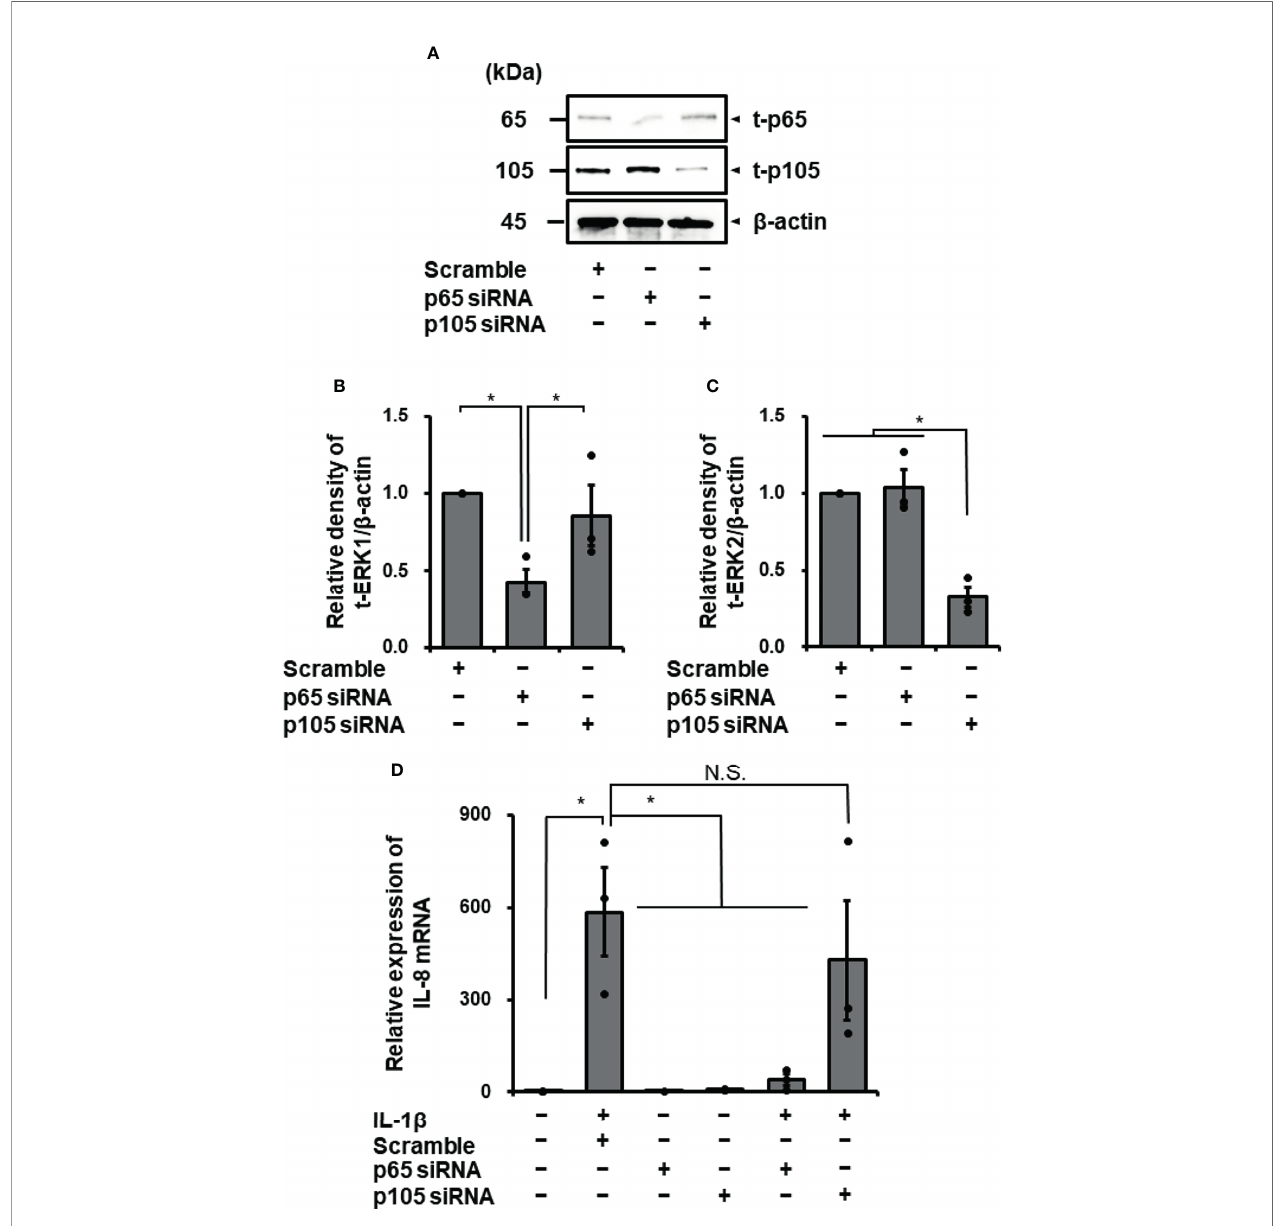
FIGURE 5 | Transfection with p65 siRNA attenuated IL-1 b -mediated IL-8 mRNA expression in canine cardiac fi broblasts but not that with p105 siRNA. In canine cardiac fi broblasts transfected with p65, p105, and scrambled siRNAs, expression of t-p65, t-105, and b -actin was detected by western blotting. The expression of p65 or p105 was reduced in fi broblasts transfected with p65 or p105 siRNA, respectively, but not in fi broblasts transfected with scrambled siRNA. b -actin was used as an internal standard. Representative results (A) and relative density of protein expression of t-p65 (B) or t-p105 (C) in siRNA-transfected fi broblasts compared with those in scrambled siRNA-transfected fi broblasts are depicted. (D) Cardiac fi broblasts transfected with p65, p105 and scrambled siRNAs were incubated with or without IL-1 b (100 pM) for 24 h After the incubation, IL-8 mRNA expression was determined. HRPT1 was used as an internal standard. Transfection with p65 siRNA resulted in reduction of IL-1 b -mediated IL-8 mRNA expression, while p105 and scrambled siRNA-transfection did not. Results have been represented as mean ± standard error (SE) from biological triplicates. *P <0.05; N.S, Not Signi fi